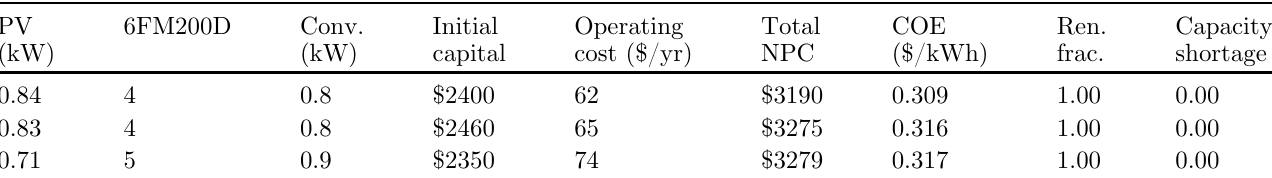
Table 2. SWPS optimum solutions (cid:3) HOMER.